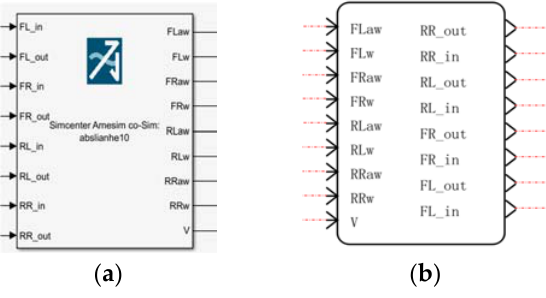
Figure 9. Interface block of co-simulation. ( a ) Simcenter Amesim co-Sim Module in Simulink; ( b ) Interface block of SimuCosim in AMESim.